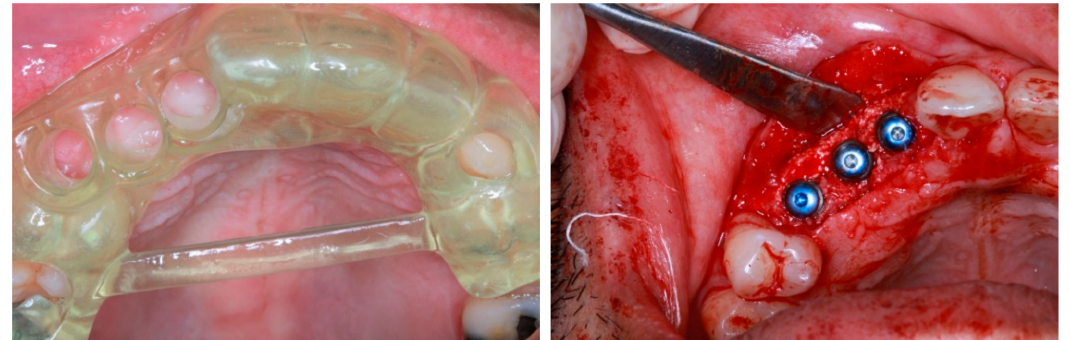
Figure 4. The example of a surgical implant guide (left) virtually designed via a specialized computer software to allow a precise and accurate implant placement with the desirable inter implant distance as depicted on the right picture. The surgical guide is produced by utilizing an additive manufacturing method manufactured by a 3D